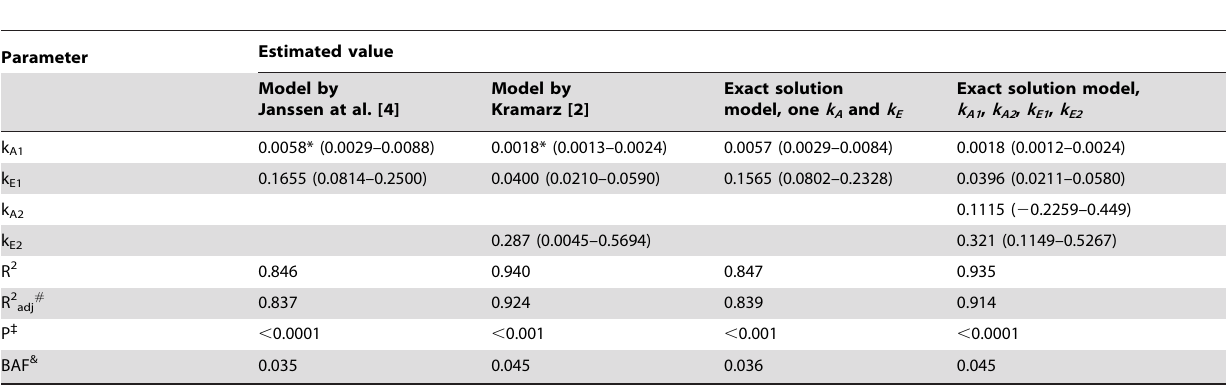
Please refer to Table 1 for symbols description. *- calculated value from estimated parameter a (metal accumulation rate) for the corresponding model. # - R 2 adjusted for degrees of freedom. & - bioaccumulation factor (BAF) calculated based on assimilation and elimination constants for the first stage of the one-compartment models ( k